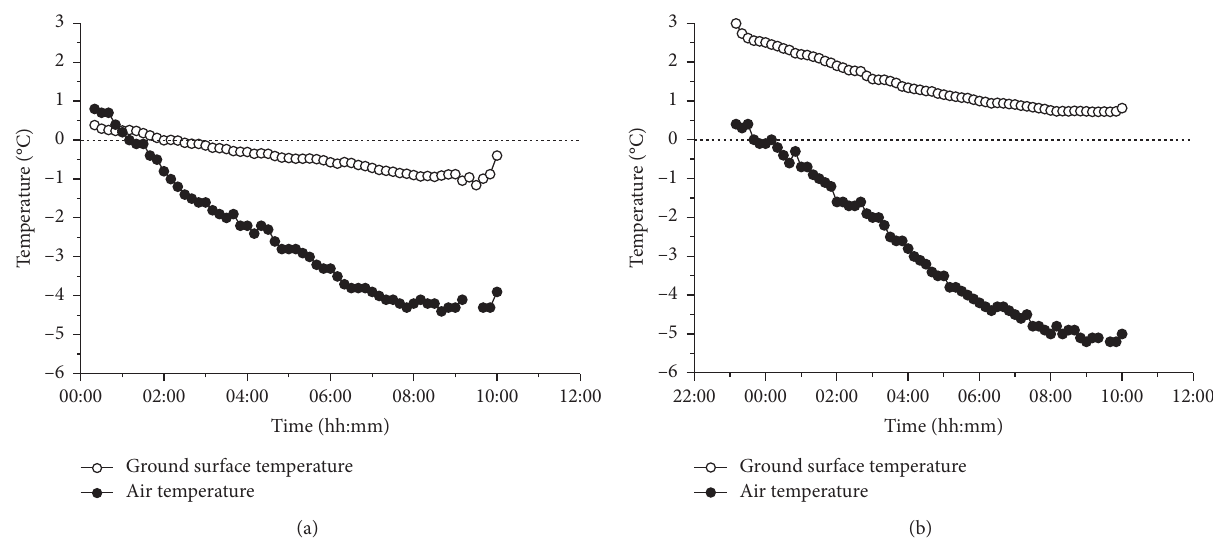
Figure 12: Variation of air temperature and ground surface temperature of the loose gravelly soil with covering the thermal insulation materials with time. (a) December 9, 2018. (b) December 14,